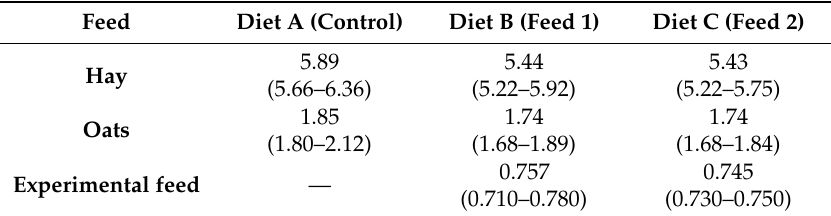
Table 2. Daily allowances of hay, oats and experimental feeds (Feed 1 or Feed 2) fed in each dietary treatment (DM kg / day) (with